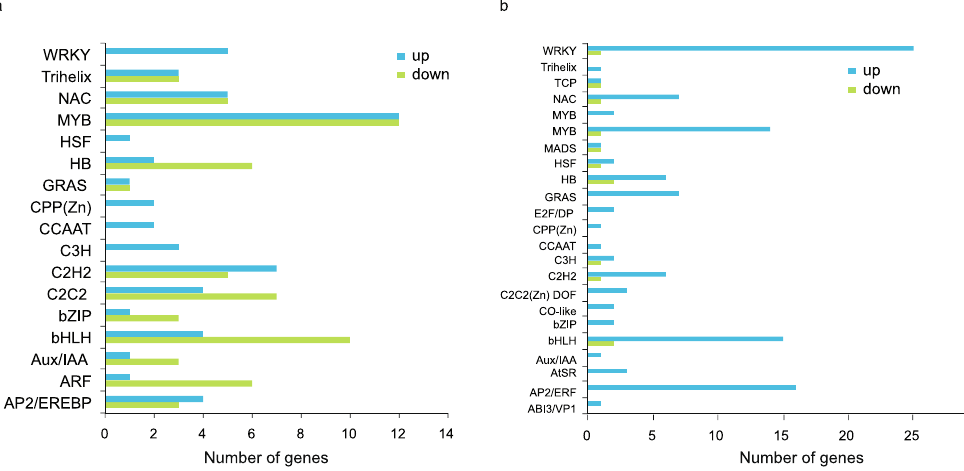
Figure 6. Transcription factor analysis of middle- ( a ) and late- ( b ) responsive genes. The numbers of up- regulated genes and down-regulated genes comparing to 0 h were showed with blue (up) and green (down),